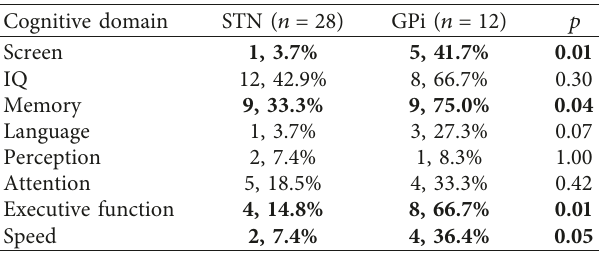
Table 4: Cognitive performance before DBS: proportion impaired in each